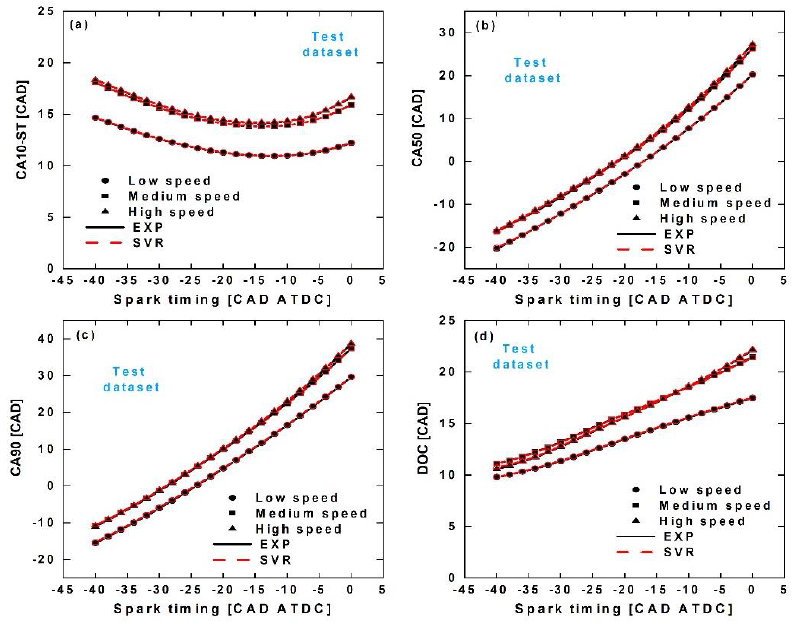
Figure 11. Effect of spark timing on the combustion phasing, at constant intake pressure (1 bar). ( a ) CA10 − ST; ( b ) CA50; ( c ) CA90; and ( d ) DOC.